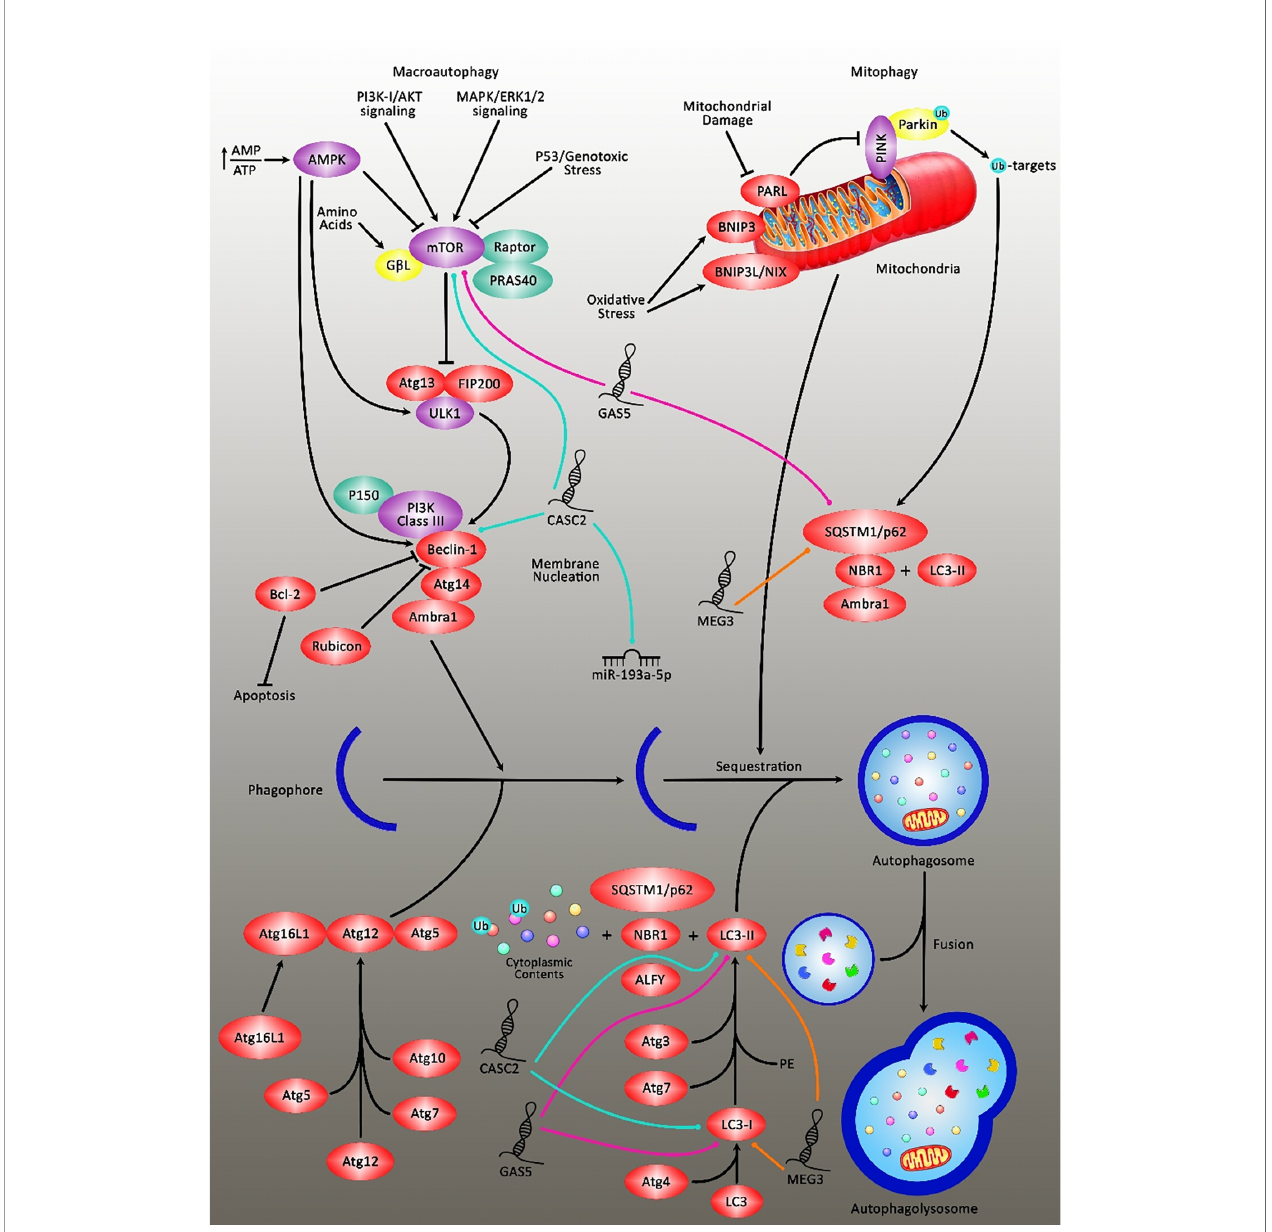
FIGURE 2 | A schematic diagram of the inhibition of autophagy cascade via long noncoding RNAs in glioblastoma in an mTOR ‐ dependent manner. Overexpression of lncRNA CASC2 could downregulate the expression level of miR-193a-5p, which could, in turn, lead to reducing temozolomide-induced autophagy and promoting cell death through suppressing the expression level of mTOR, and thereby resulting in enhancing the sensitivity of glioma cells to temozolomide cytotoxicity to the large extent (55). Furthermore, the elevation of lncRNA GAS5 could enhance glioma cell sensitivity to cisplatin. Cisplatin could evoke excessive autophagy concomitant via promoting and suppressing the expression levels of LC3II and p62 respectively, which was negatively inhibited after GAS5 overexpression. Therefore, GAS5 could attenuate the resistance of glioma cells to cisplatin by restraining excessive autophagy through the activation of mTOR signaling (54). Also, upregulation of MEG3 could eliminate cisplatin-induced autophagy in glioma cells via directly targeting LC3II and p62 in tumor cells. The suppression of autophagy or knockdown of ATG5 could reverse the reduction in cell apoptosis caused by MEG3 knockdown in glioma cells treated with cisplatin